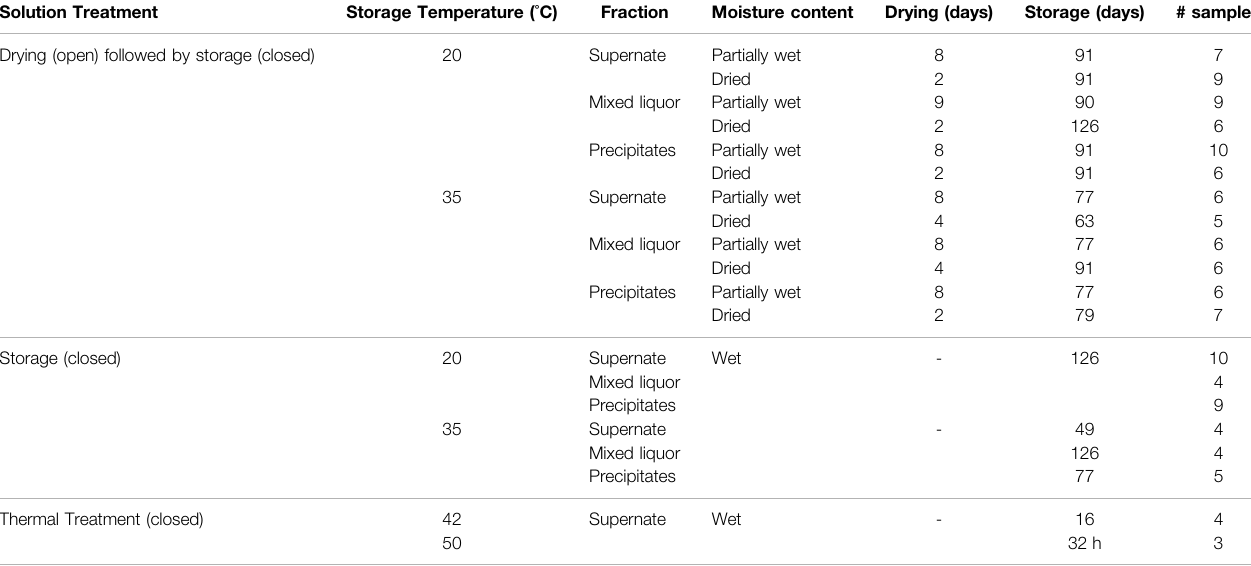
TABLE 2 | Three solution treatments (Drying and Storage, Storage and Thermal treatment) were applied to the three urine/Ca(OH)2 fractions (Mixed liquor, Supernate, and Precipitate) in which inactivation of Ascaris was assessed. Wet conditions had > 90% moisture content (MC). Partially wet (P. wet) conditions had 73 – 82% MC (no free liquid on the surface); and Dried conditions had 13 – 33% MC. During drying, the containers were open. During storage, the containers were sealed.